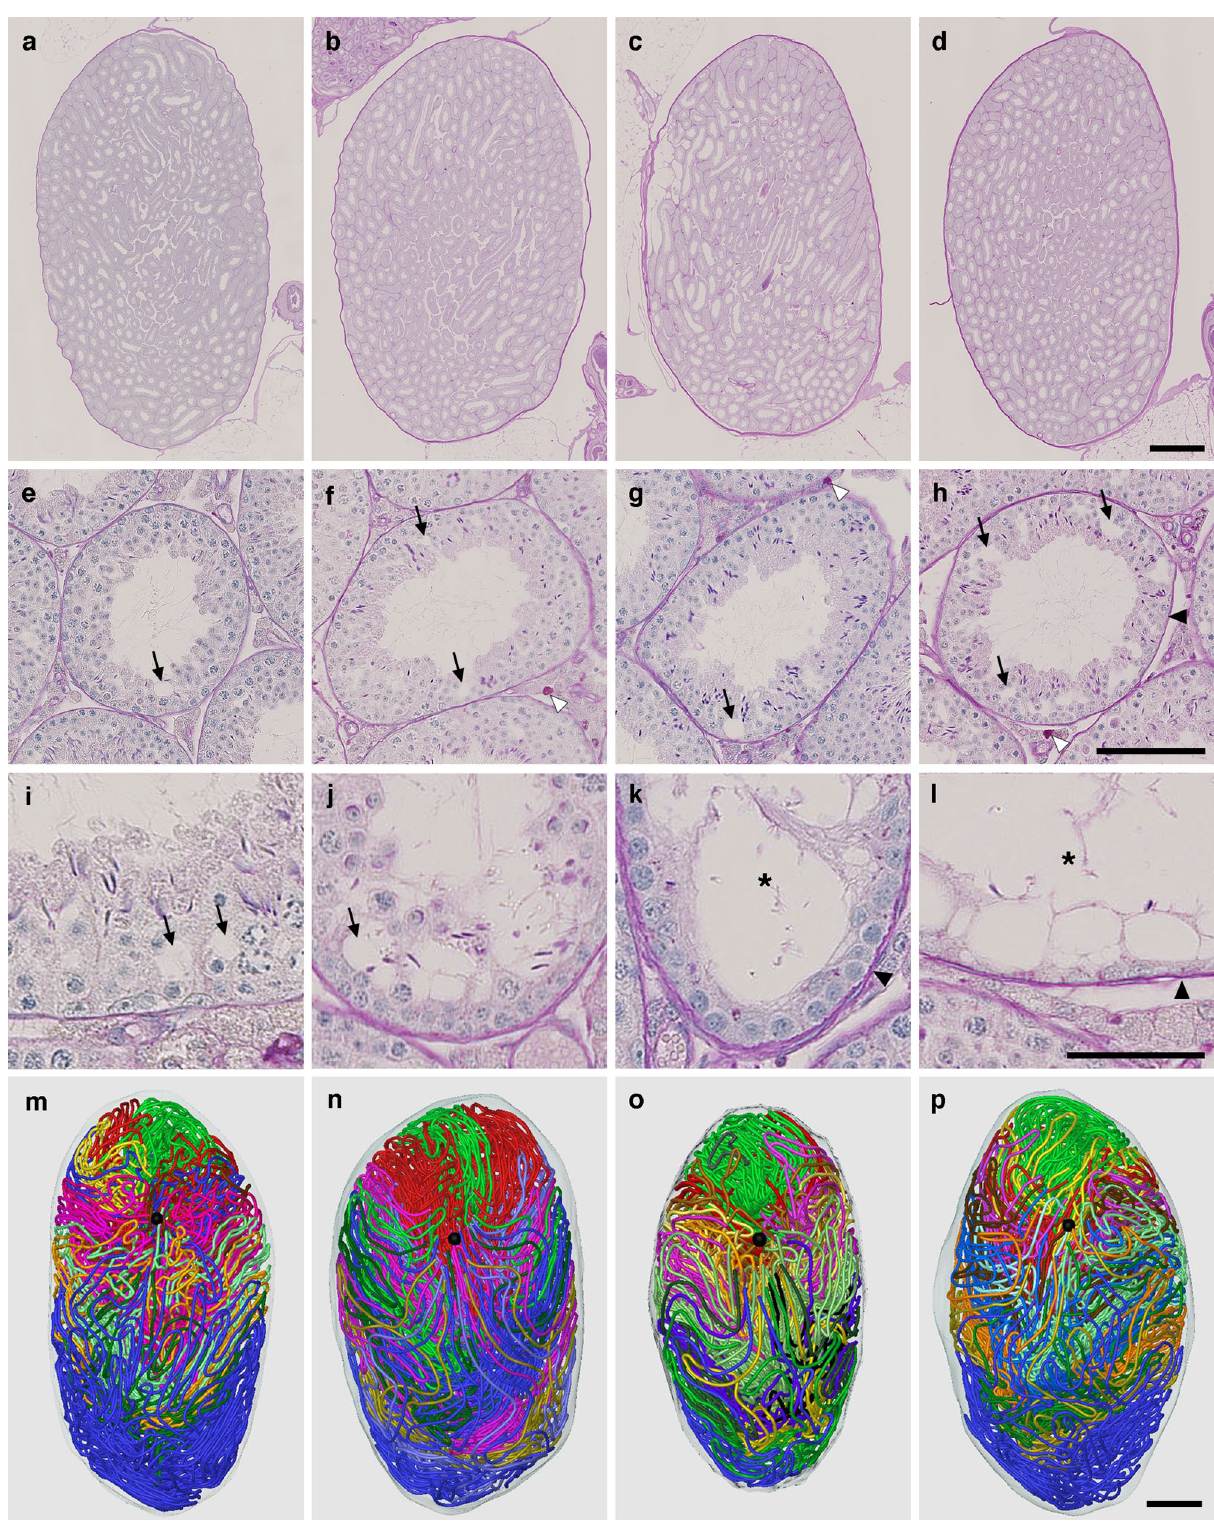
Figure 1. Reconstruction of all seminiferous tubules in representative testes at 12, 18, 24, and 30 months. ( a – l ) PAS-H-stained longitudinal sections of testes #2 ( a , e , i ), #5 ( b , f , j ), #7 ( c , g , k ), and #12 ( d , h , l ), which represent 12, 18, 24, and 30 months, respectively, are shown at low ( a – d ) and high magnifications ( e – l ). ( m – p ) The 3D core lines of all reconstructed seminiferous tubules marked with different colors are shown ( m , n , o , p for testis #2, 5, 7, and 12, respectively) with the position of the rete testis (black sphere). Arrows, vacuoles in Sertoli cells; open arrowheads, PAS-positive materials in the interstitial compartment; closed arrowheads, thickening of the basement membrane; asterisks, tubules with severely impaired spermatogenesis. Scales, 1 mm ( a – d and m – p ), 100 µm ( e – h ), and 50 µm ( i – l